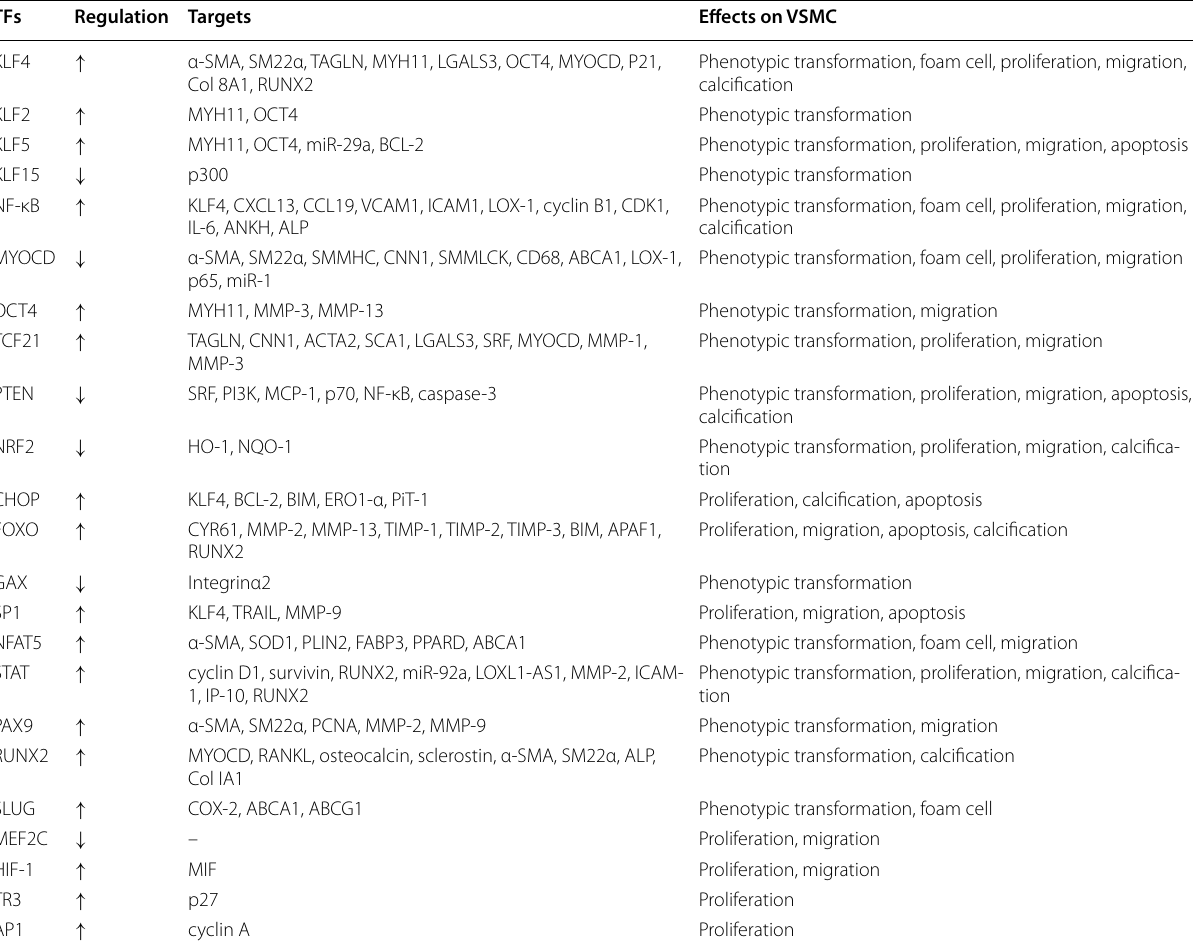
Table 1 VSMC regulation by Transcription factor in response to atherosclerosis